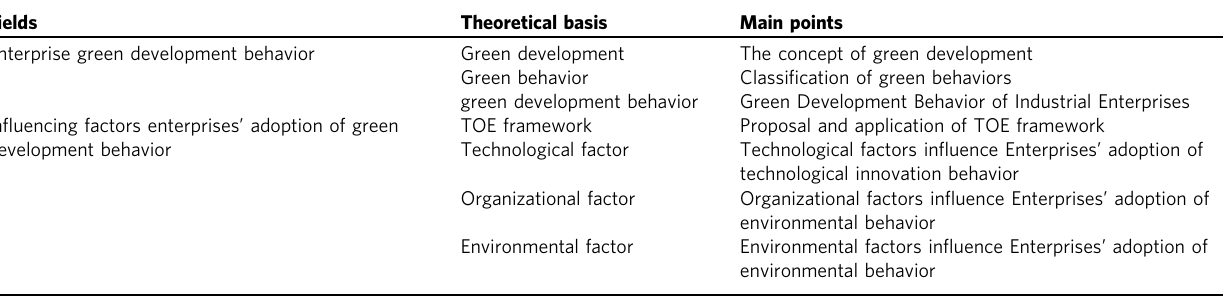
TOE framework is technology – organization – environment